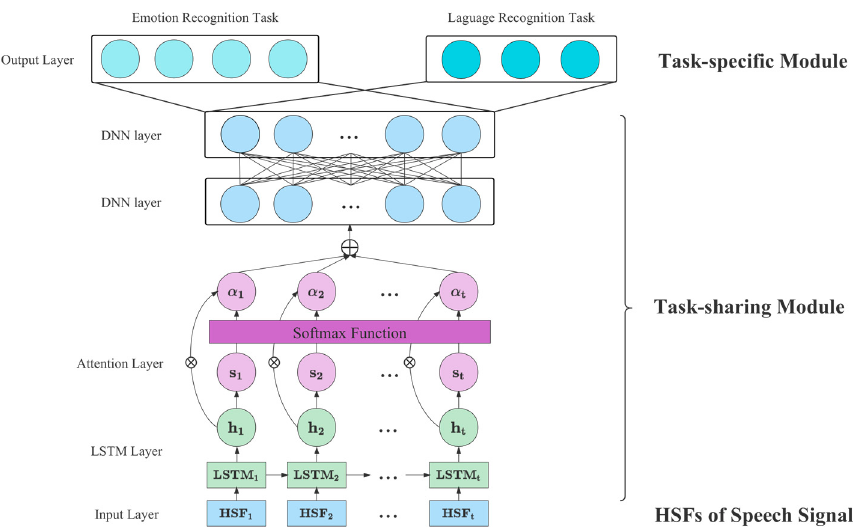
Figure 2. The overview of the MSFL model.